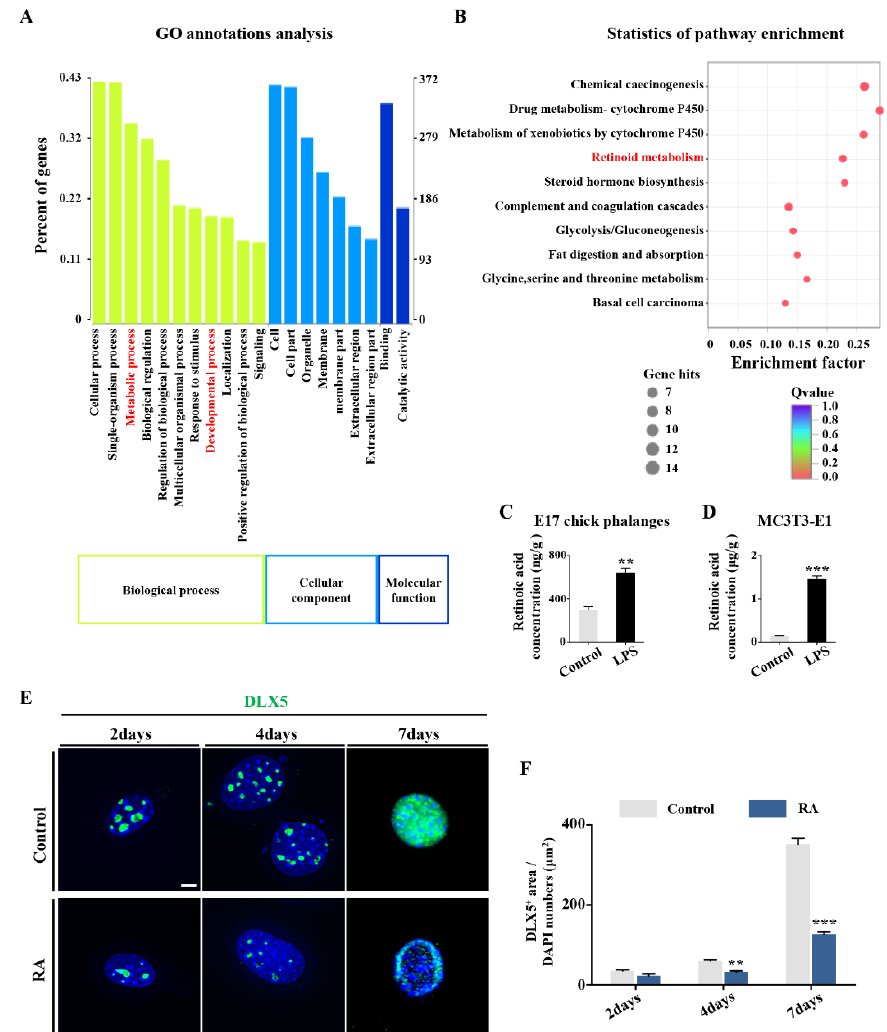
Figure 6. Determining the principal genes modulating osteogenesis following LPS treatment. ( A , B ) RNA sequencing transcript profiling showing the significantly altered signaling pathways identified using GO analysis ( A ) and KEGG analysis ( B ). ( C , D ) Bar charts showing RA concentration in E17 chick phalanges and MC3T3-E1 cells of control and LPS-treated groups. Units represent measured RA concentration normalized to total protein. ( E ) Representative images of DLX5 immunofluorescent staining of MC3T3-E1 cells from control and RA-treated groups, after being cultured for 2, 4, and 7 days, counterstained with DAPI. Negative controls were shown in Supplementary Materials (Figure S7). ( F ) Dlx5 expression in each cell was quantified with the ratio of DLX5-positive area to total DAPI-positive cell numbers. Scale bars = 6 µ m in ( E ). (** p < 0.01, *** p < 0.001)